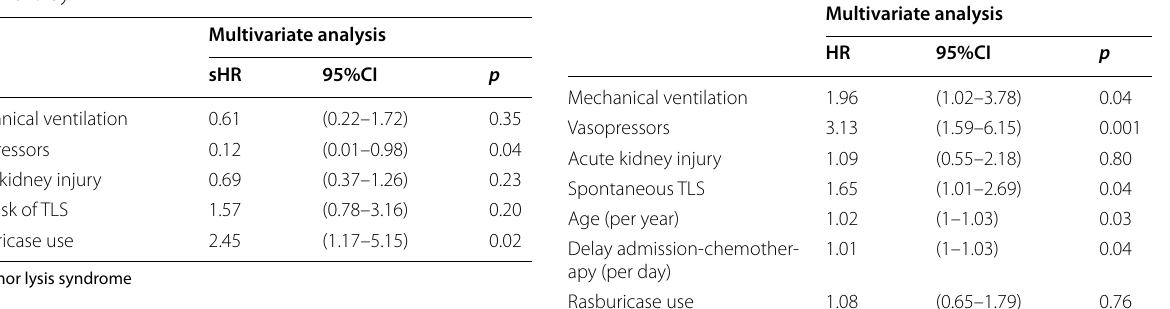
Table 4 Covariates associated with remission at one year by Fine and Gray